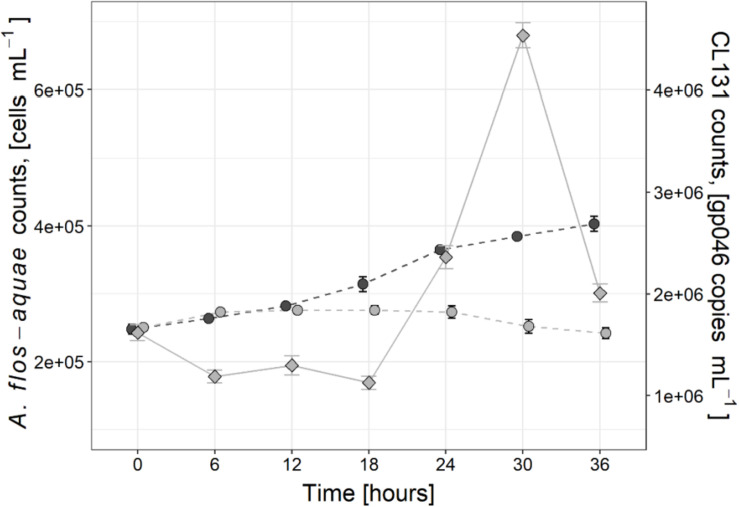
Changes in Aphanizomenon flos-aquae strain 2012/KM1/D3 cell abundance (circles) in the control (dark gray) and infected (light gray) treatments as well as dynamics of cyanophage vB_AphaS-CL131 gp046 gene copy numbers (diamonds) during the course of incubation experiment. Symbols indicate the mean values, and the error bar shows the standard deviation of three technical replicates.